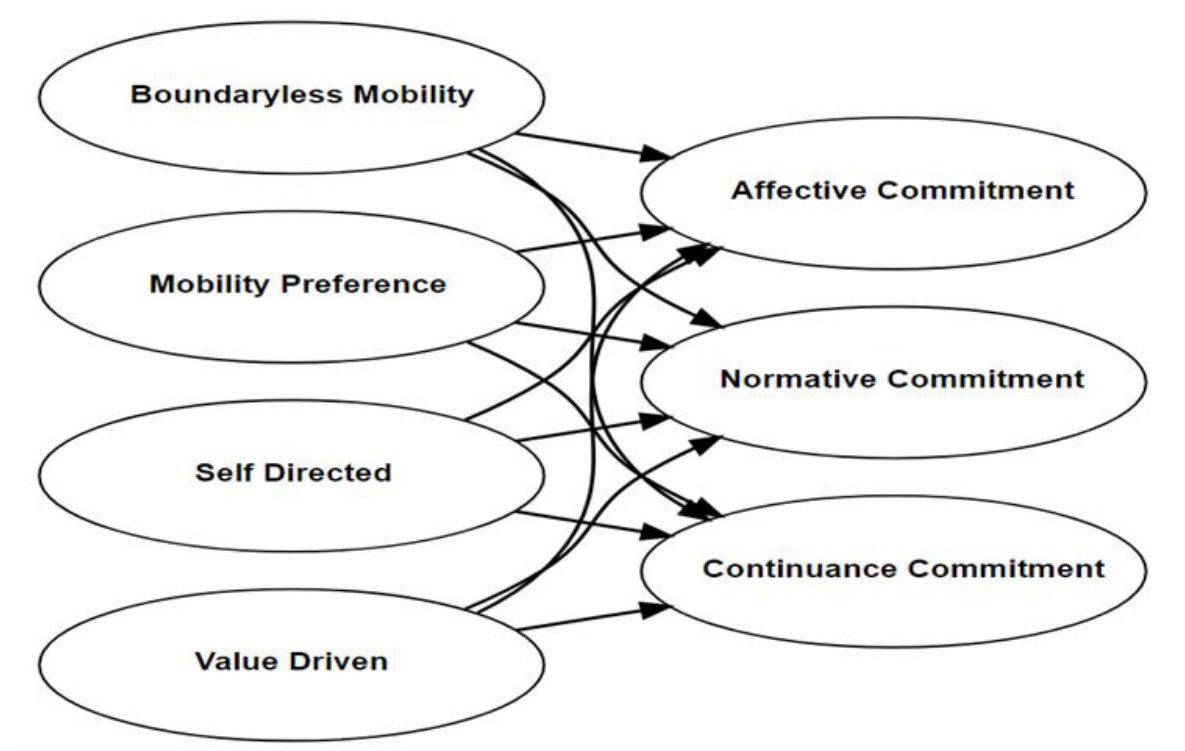
Figure 2. Conceptual Model (Hypothesized Relationship among Variables).